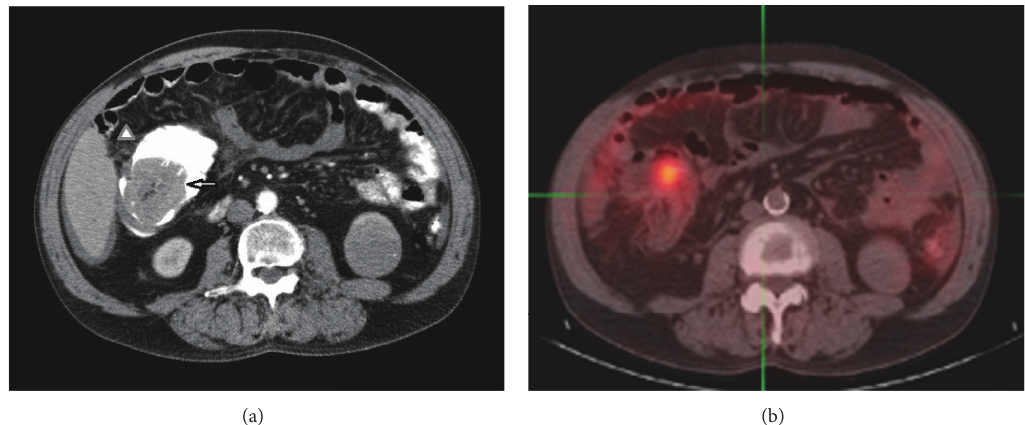
Figure 1: Abdominal imaging. (a) Computed tomography and (b) positron emission tomography scans showed a 5.8 cm partially obstructing cecal mass (arrow) with ascites and peritoneal